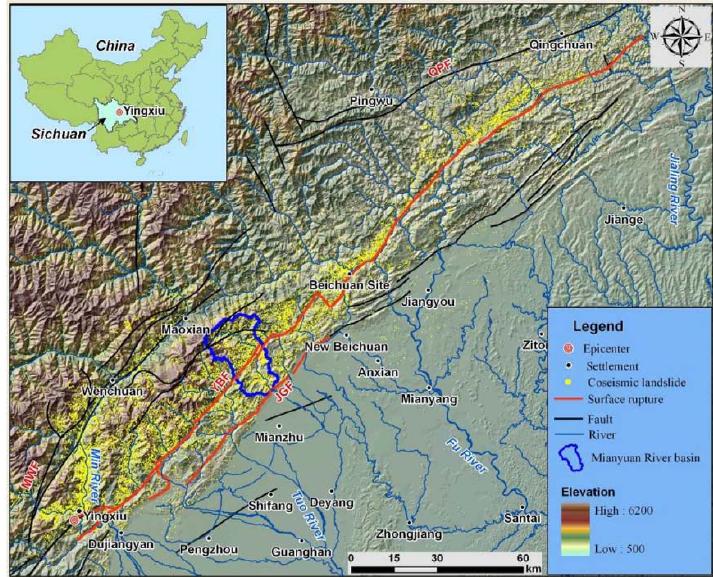
Figure 1. Location of the study area—the Mianyuan River basin. MWF: Miaoxian–Wenchuan Fault, YBF: Yingxiu–Beichuan Fault, JGF: Jiangyou–Guanxian Fault, QPF: Qingchuan – Pingwu Fault [5].